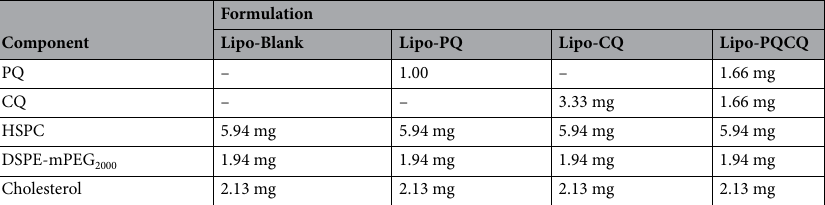
Table 3. Formulation of blank and drug-loaded liposomes. PQ primaquine, CQ chloroquine, HSPC hydrogenated soybean phosphatidylcholine, DSPE‑mPEG2000 distearoyl- sn -glycero-3-phosphoethanolamine- N-(methoxy[polyethylene